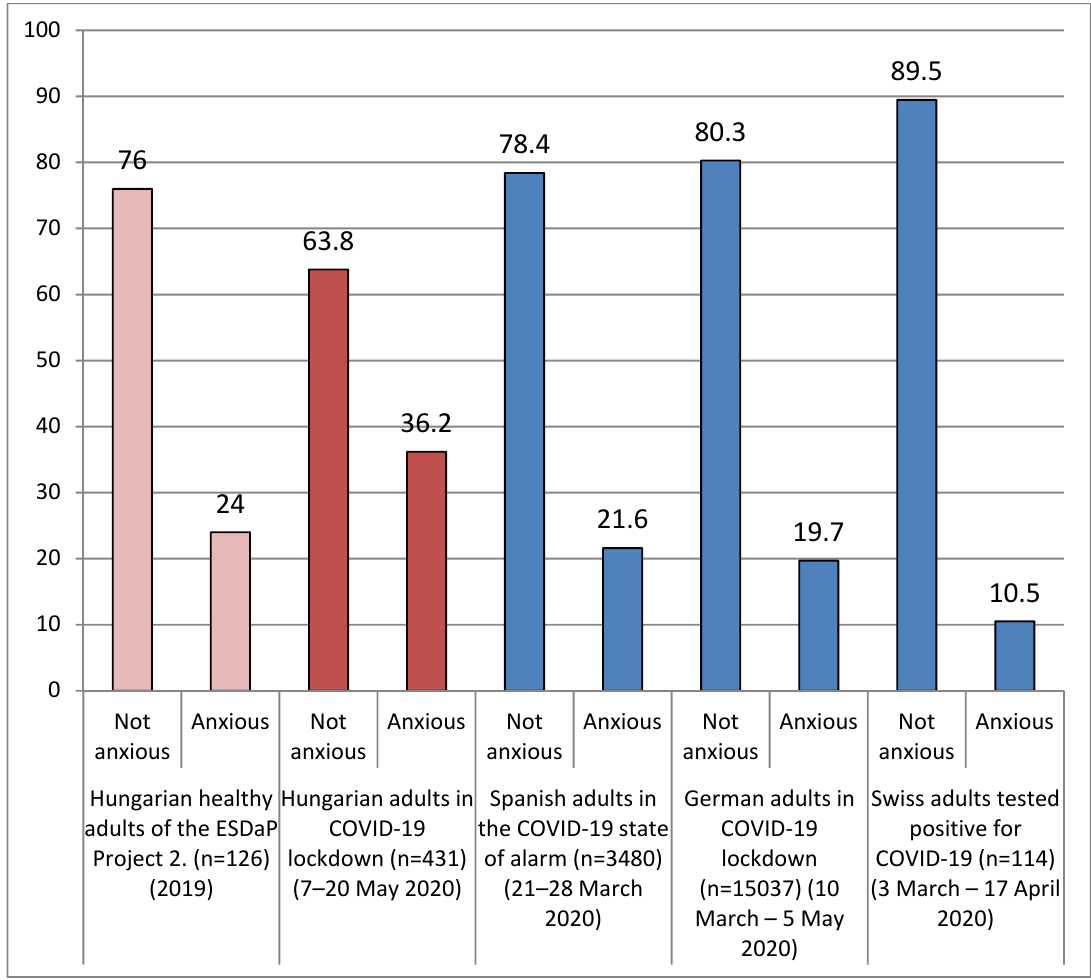
Figure 3. Frequencies of anxious versus not anxious cases (measured with the General Anxiety Disorder Assessment (GAD)-2 scale) at Hungarian adults ( n = 431) during coronavirus lockdown compared to previous Hungarian scores and other countries’ residents’ scores during the COVID-19 pandemic.